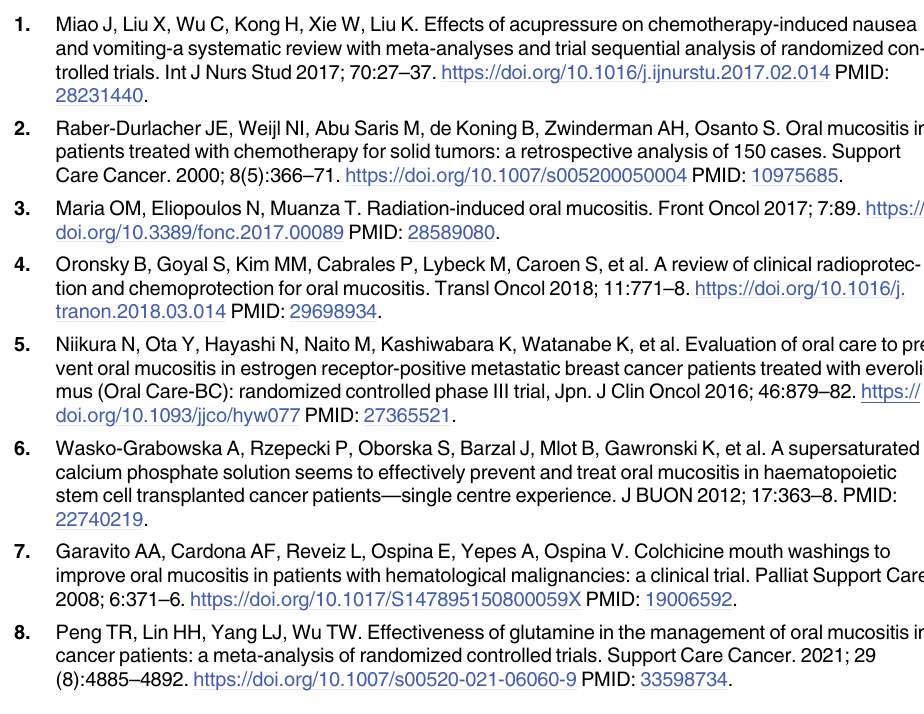
S2 Table. Rank probability to be the best treatment (PrBest) by the incidence of radiother- apy-induced moderate-severe oral mucositis of each treatment in patients with cancer. S3 Table. Results of the incidence of moderate-severe oral mucositis in patients with head and neck cancer. S4 Table. Results of the incidence of radiotherapy-induced moderate-severe oral mucositis in patients with cancer. S5 Table. Results of the incidence of moderate-severe oral mucositis. a. Excluding the study performed by Roopashri et al. b. Excluding the study performed by Roopashri and Costa et